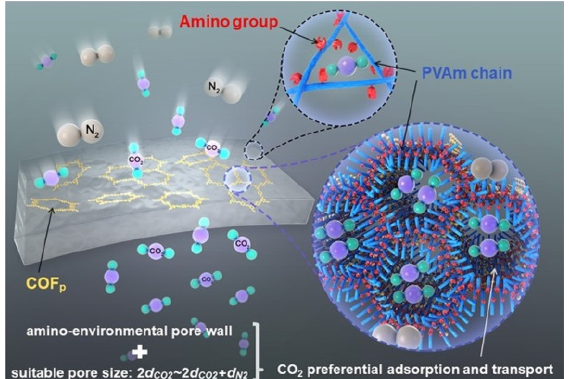
Figure 19. Schematic of COFp-PVAm membranes. Oversized COFp are penetrated by PVAm to create appropriately sized CO2-selective channels. d: kinetic diameter. Reprinted with permission from [142], Copyright (2019) American Chemical Society.